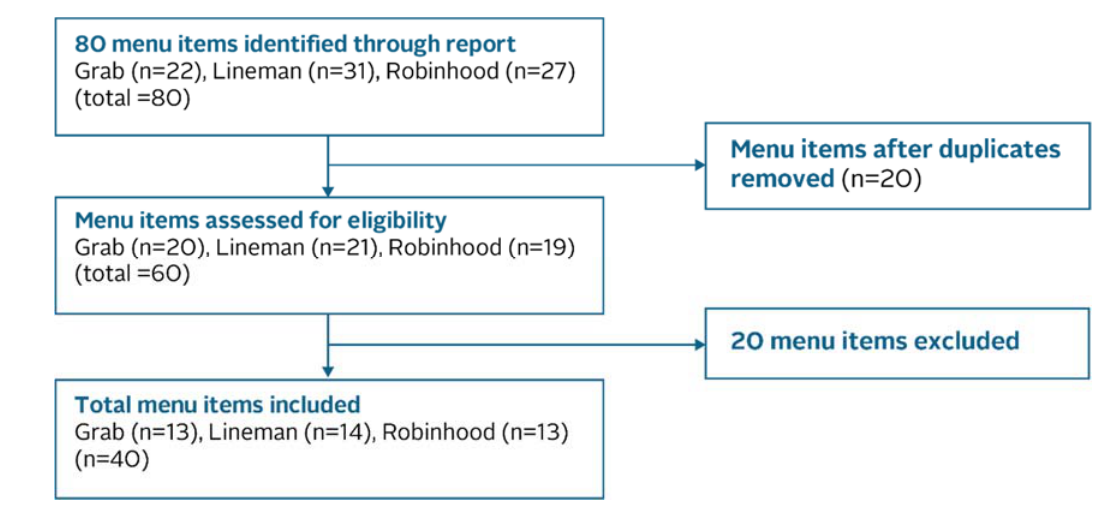
Figure 1. Sampling